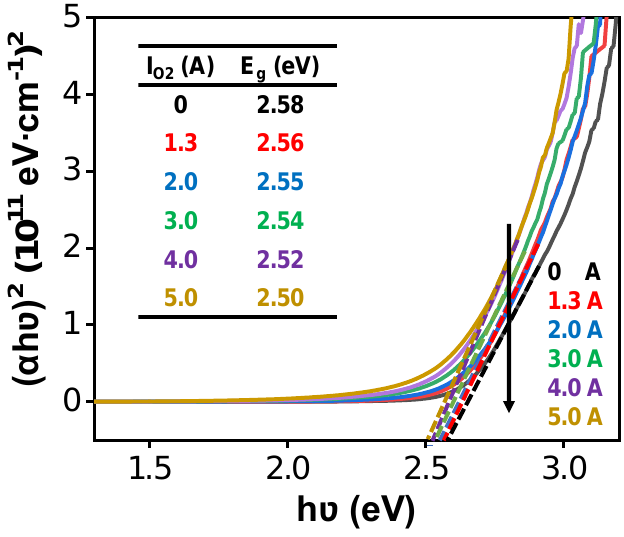
Figure 7. The variation of the direct band gap of Cu 2 O films.